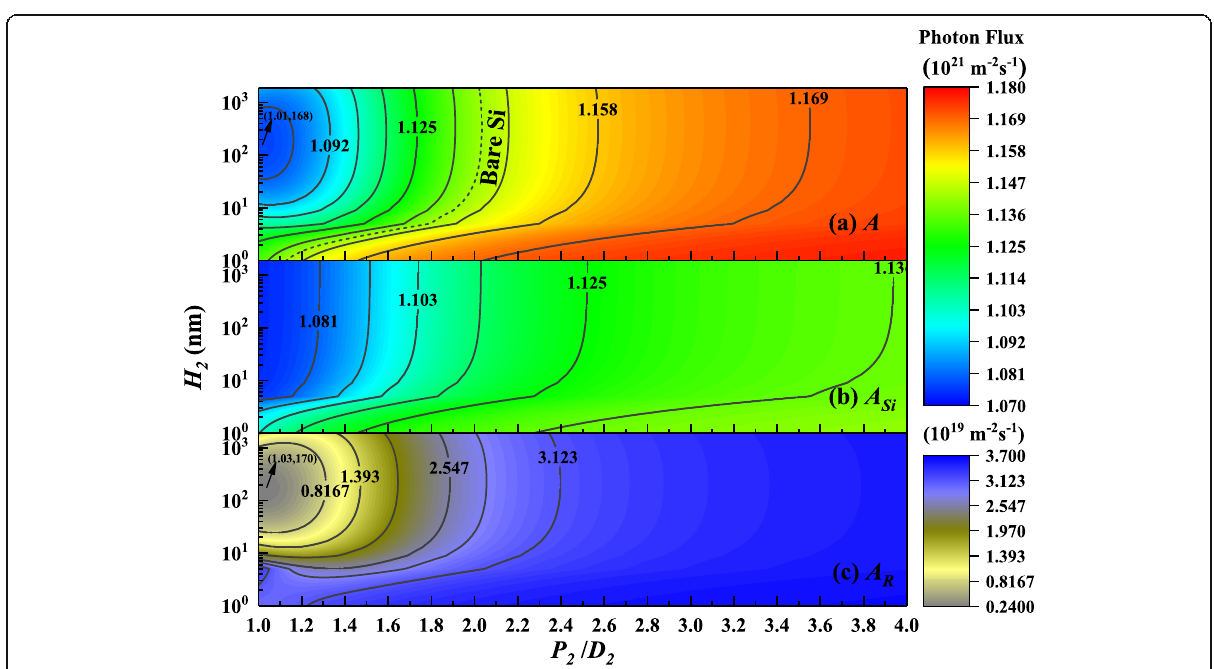
Fig. 5 Contour maps of the photon absorption distribution in different parts for RPG structure. ( a ) The total photon absorption A . ( b ) The photon absorption of CS part A Si . ( c ) The photon absorption of the rear surface gratings A R . (The dotted line in the illustration represents the absorption of